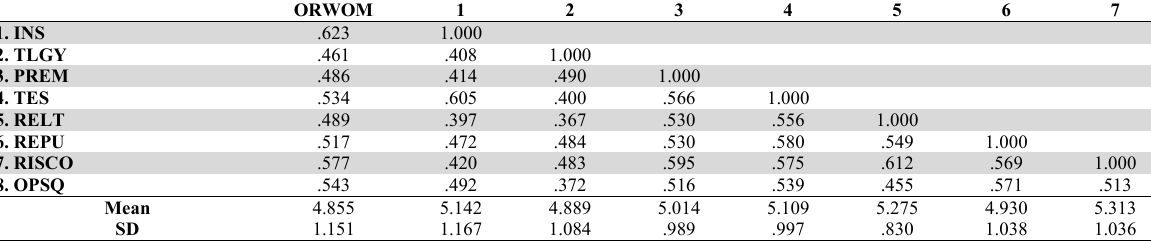
Pearson Correlations between all variables of the Research Model ORWOM